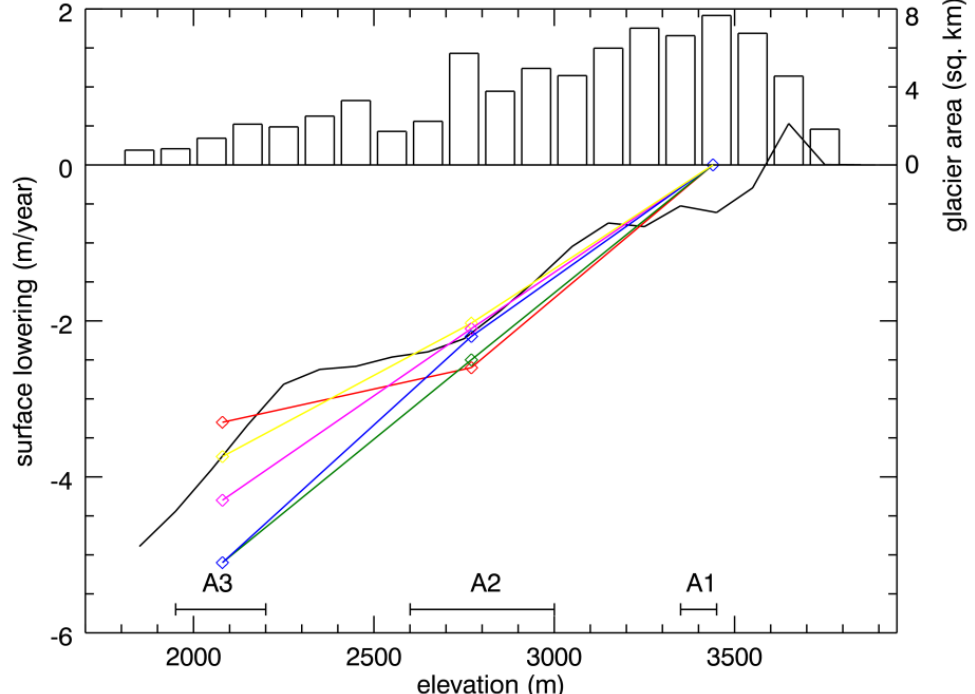
Figure 8. Glacier hypsometry (upper panel) and surface lowering in elevation bands of 100 m derived from the subtraction of two Airphoto DEMs (black line) and surface lowering from ICESat measurements using the Airphoto DEM (red), SRTM-C DEM (green), the ASTER GDEM original (blue) and the ASTER GDEM smoothed version (magenta) as elevation reference and from SIMU-Laser (wellow) . The subtraction of the two DEMs and the ICESat measurements cover slightly different periods: 1999–2009 and 2003–2009, respectively. The elevation ranges covered with the ICESat data (A1, A2 and A3) are marked by horizontal lines in the lower part of the